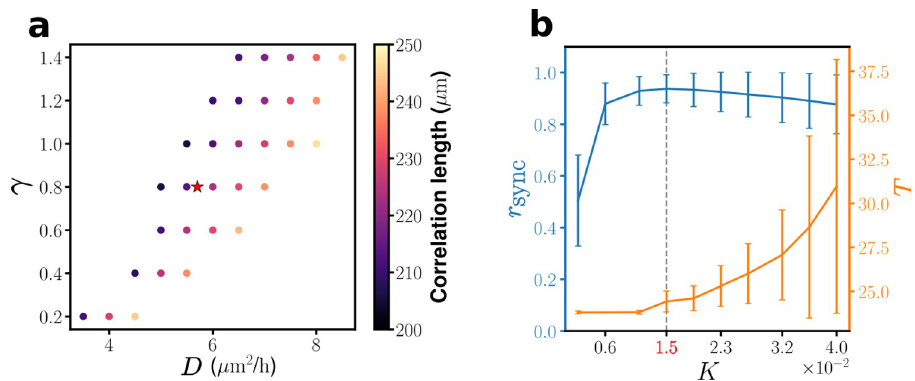
Fig 5. Determination of three key parameters γ , D , and K guided by the analysis of experimental data. (a) Colormap of the mean correlation length of diffusion-only mediated phase waves, in the absence of network coupling (i.e., K = 0). The star symbol marks the position of the selected choice of ( γ , D ) = (0.8, 5.7 μ m 2 /h), which be used for all full (i.e., K 6¼ 0) model simulations. (b) The degree of (population) phase synchrony r sync and (population) mean period T of the model SCN. The error bars represent the standard deviations of the values covered by all candidate model networks listed in Table 1. The dashed line in (b) marks the value of K = 1.5 × 10 − 2 , with which we could recapitulate several key properties of experimentally observed circadian phase